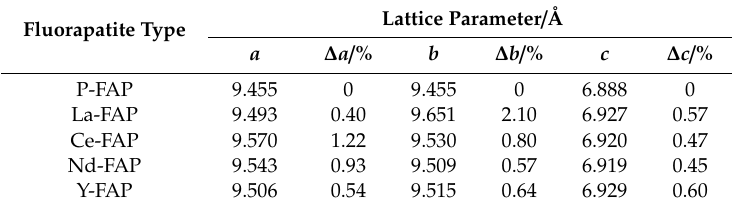
Table 1. Lattice parameters of perfect fluorapatite (P-FAP) and of REE-bearing fluorapatite (REE-FAP) crystals.